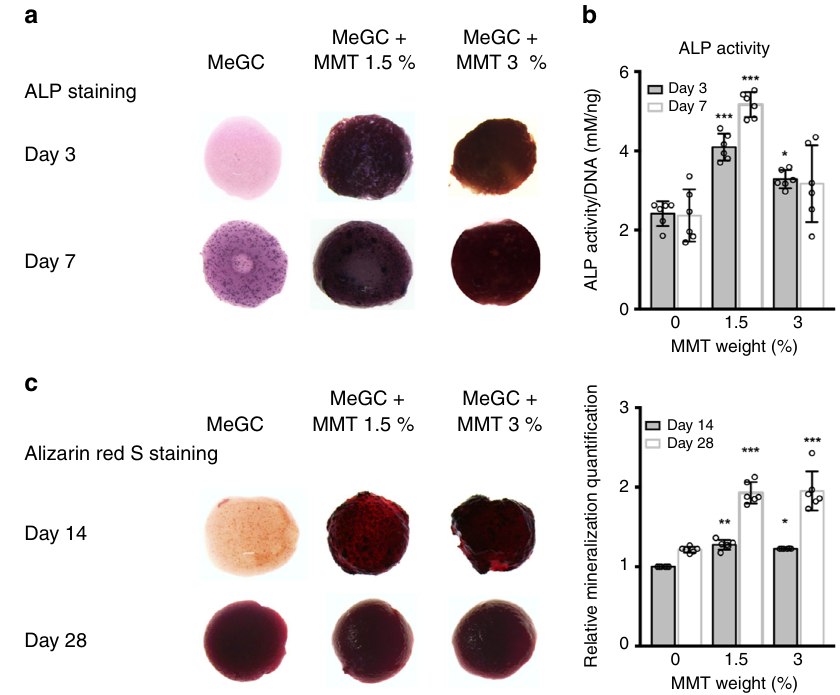
Fig. 5 Osteoconductivity in vitro. The bioactivity of encapsulated cells in photocross-linked MeGC-MMT nanocomposite hydrogels with various amount of MMT (0%, 1.5%, 3%). The hydrogels were cultured in the osteogenic medium for various time. a ALP staining and b ALP activity were performed at days 3 and 7. c Alizarin red S staining was carried out at days 14 and 28, and their quanti fi cation was also evaluated. Error bars indicate standard deviation (three independent cultures, n = 6). * p < 0.05, ** p < 0.01, and *** p < 0.001 compared with the control MeGC group with 0% MMT (ANOVA followed by Tukey ’